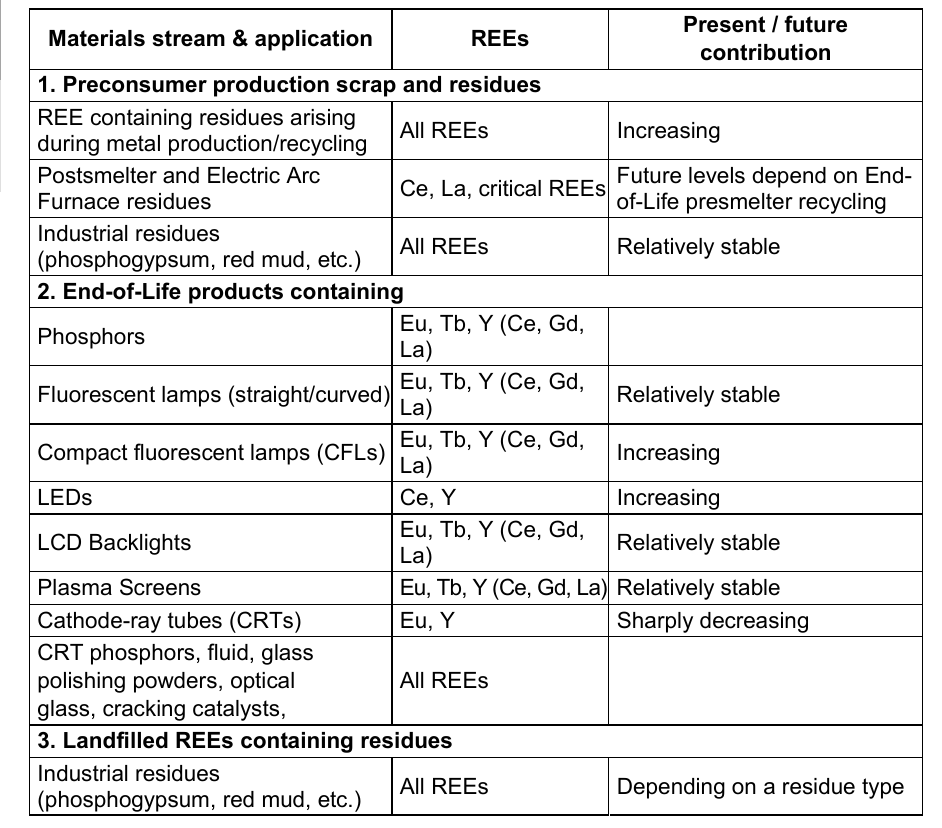
Table 1 – REE-containing streams for